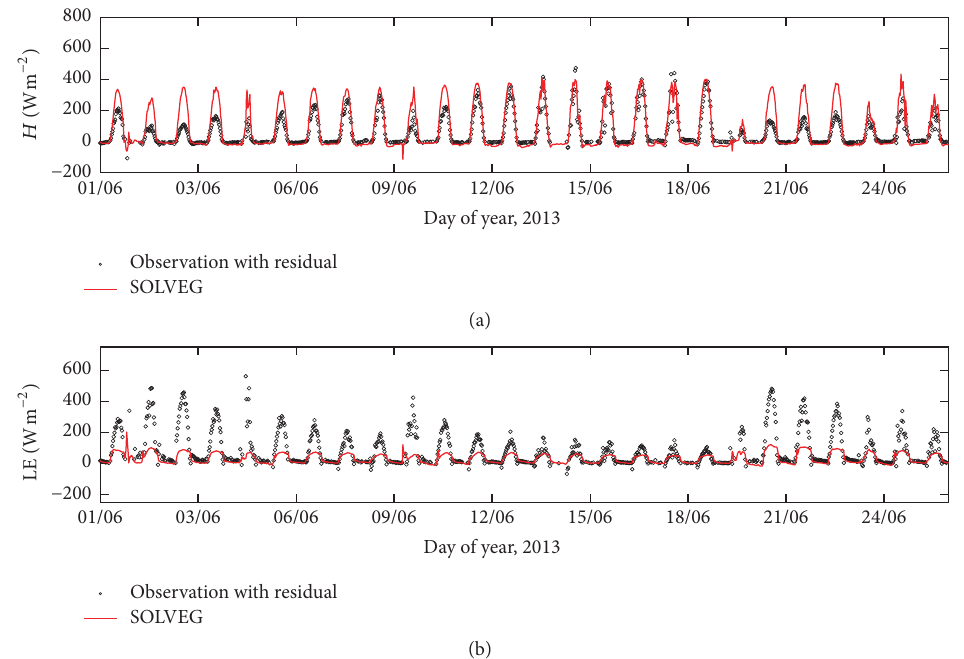
Figure 6: Temporal changes in (a) sensible heat flux and (b) latent heat flux, after the residual energy corrections during the wet